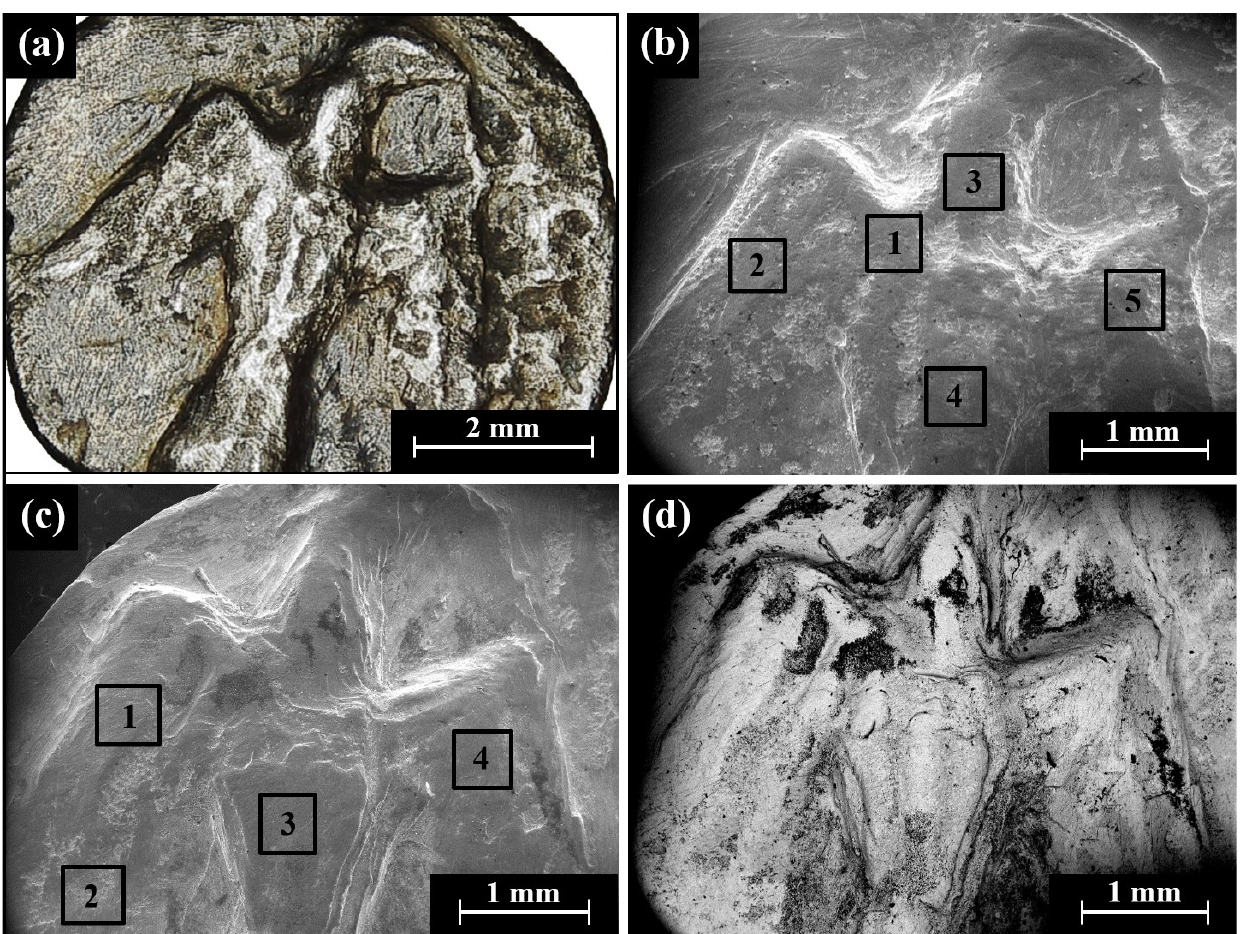
Figure 10. Images of the Edom hoard Type 16 O2/R2 coins, with the reverse side showing a design of a falcon in flight: ( a ) multi-focal LM of coin Edom hoard no. 2 (IMJ 2020.33.2); ( b ) SEM observation of coin Edom hoard no. 2 (SE mode); ( c ) coin Edom hoard no. 3 (SE mode); and ( d ) coin Edom hoard no. 3 (BSE mode). The areas inside the squares 1–5 in ( b , c ) were examined by EDS analysis. 4.7. Yehud Attic Standard Quarter Obol Type 24 O1/R2